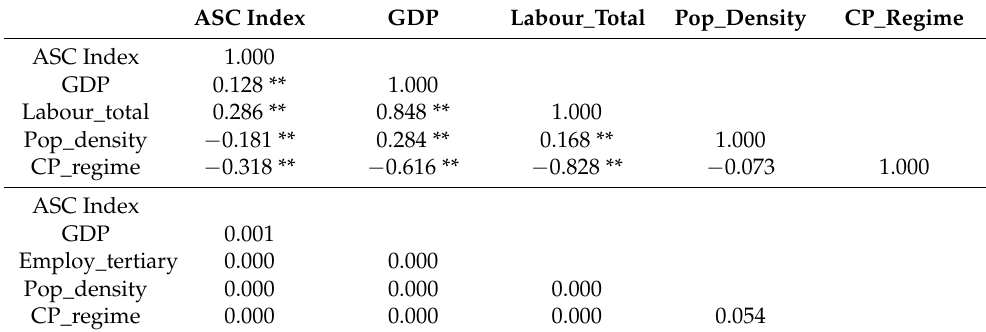
Table 3. Correlation